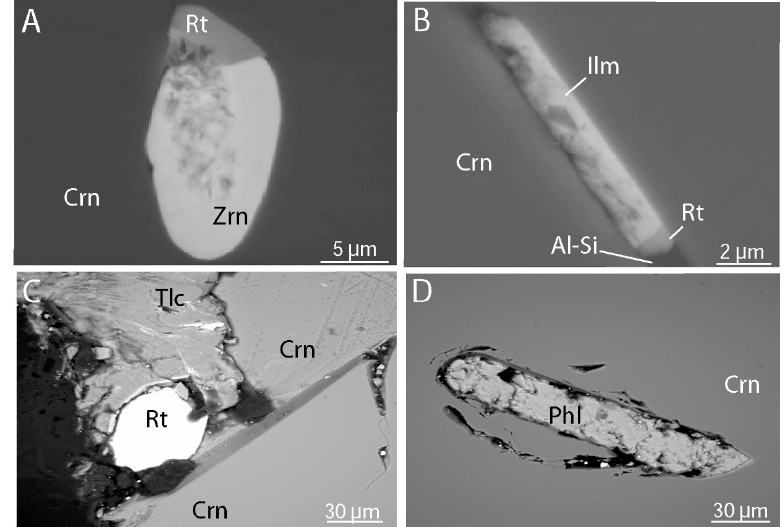
Figure 52. Inclusions in ruby from the Sahanonoka deposit in the Vatomandry area [94]. ( A ) Zircon (Zrn) associated with rutile (Rt); ( B ) rutile, ilmenite (Ilm), and Al-silicate (Al-Si); in ruby (Crn); ( C ) association of rutile and talc (Tlc) in ruby; and ( D ) phlogopite (Phl) crystal included in a ruby. The Fe contents of the rubies (1500–8460 ppm) are always higher than Cr and V. The Cr 2 O 3 contents differ with color: (i) red brown (4760–6670 ppm), (ii) red (3500–3800 ppm), (iii) pink (1390–